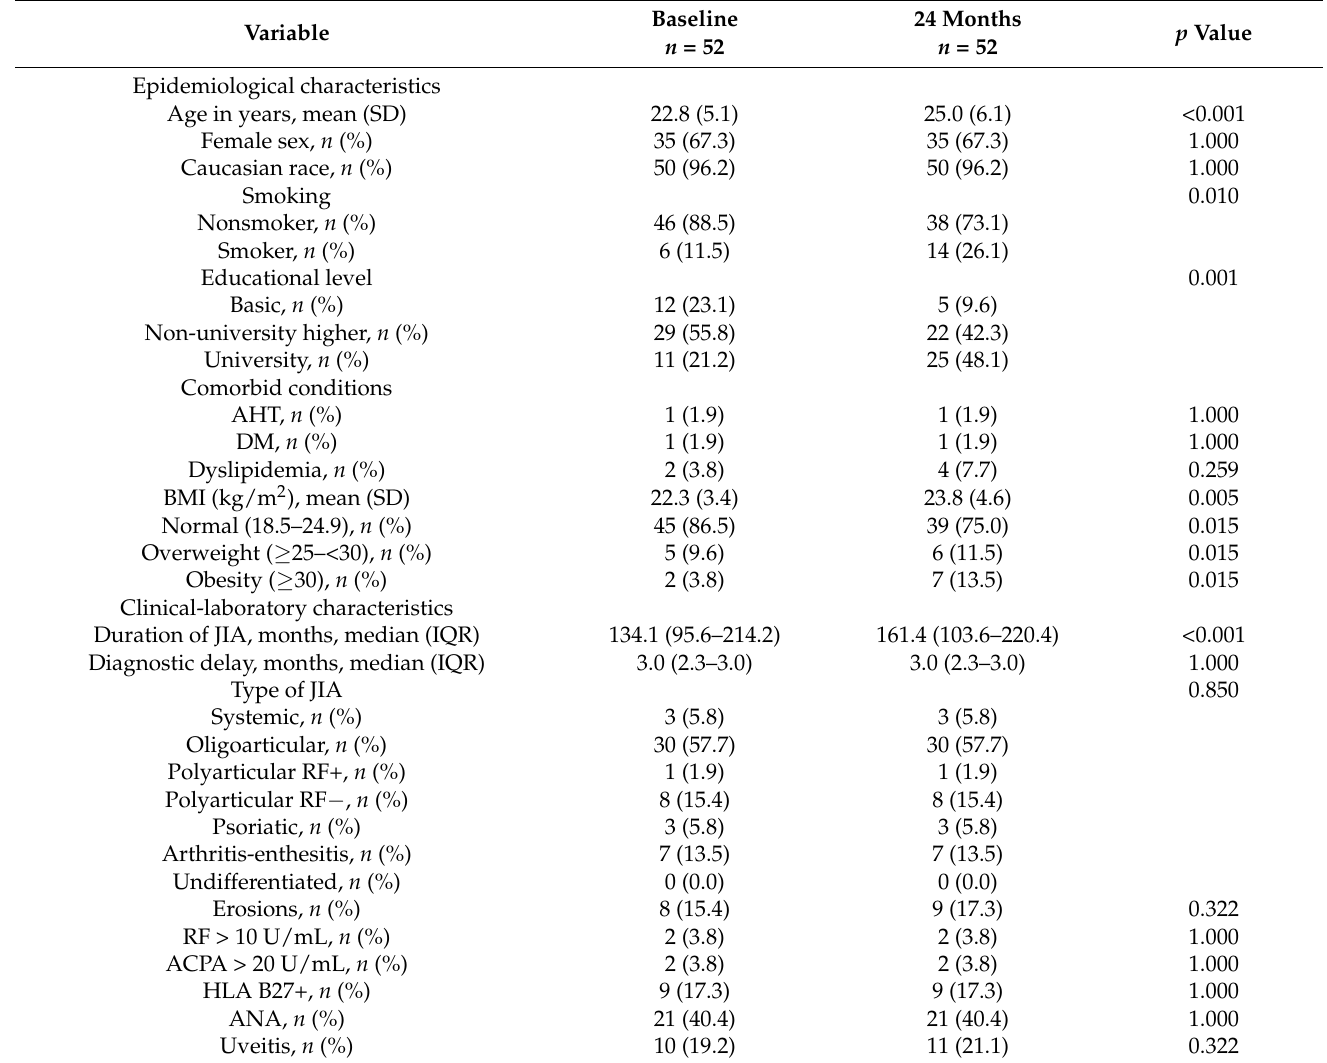
Table 1. Characteristics of 52 patients with JIA at baseline and at 24